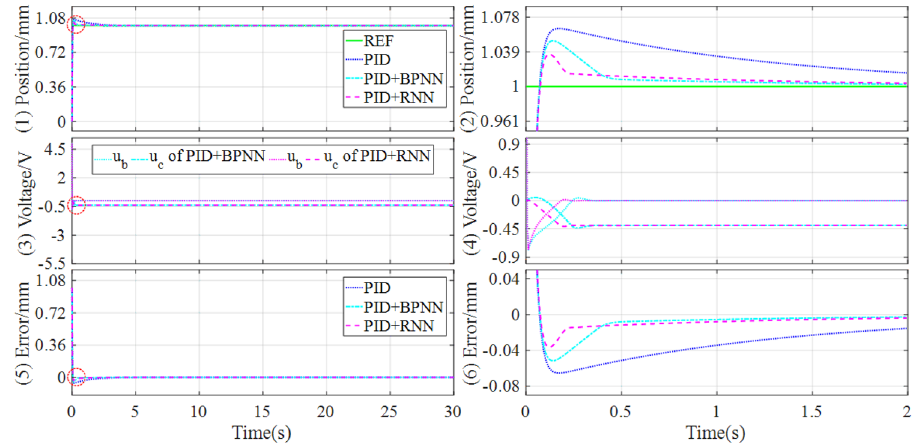
Figure 5. Simulation results of tracking step signal under the different controllers.